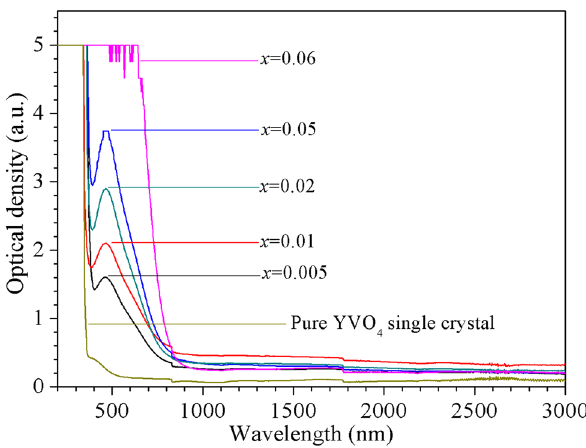
Figure 3: Ultraviolet - visible and near infrared absorption spectra of undoped YVO 4 and Ce 3 + - doped YVO 4 single crystals at room tem - perature. Noticed that the vertical axis represents the optical